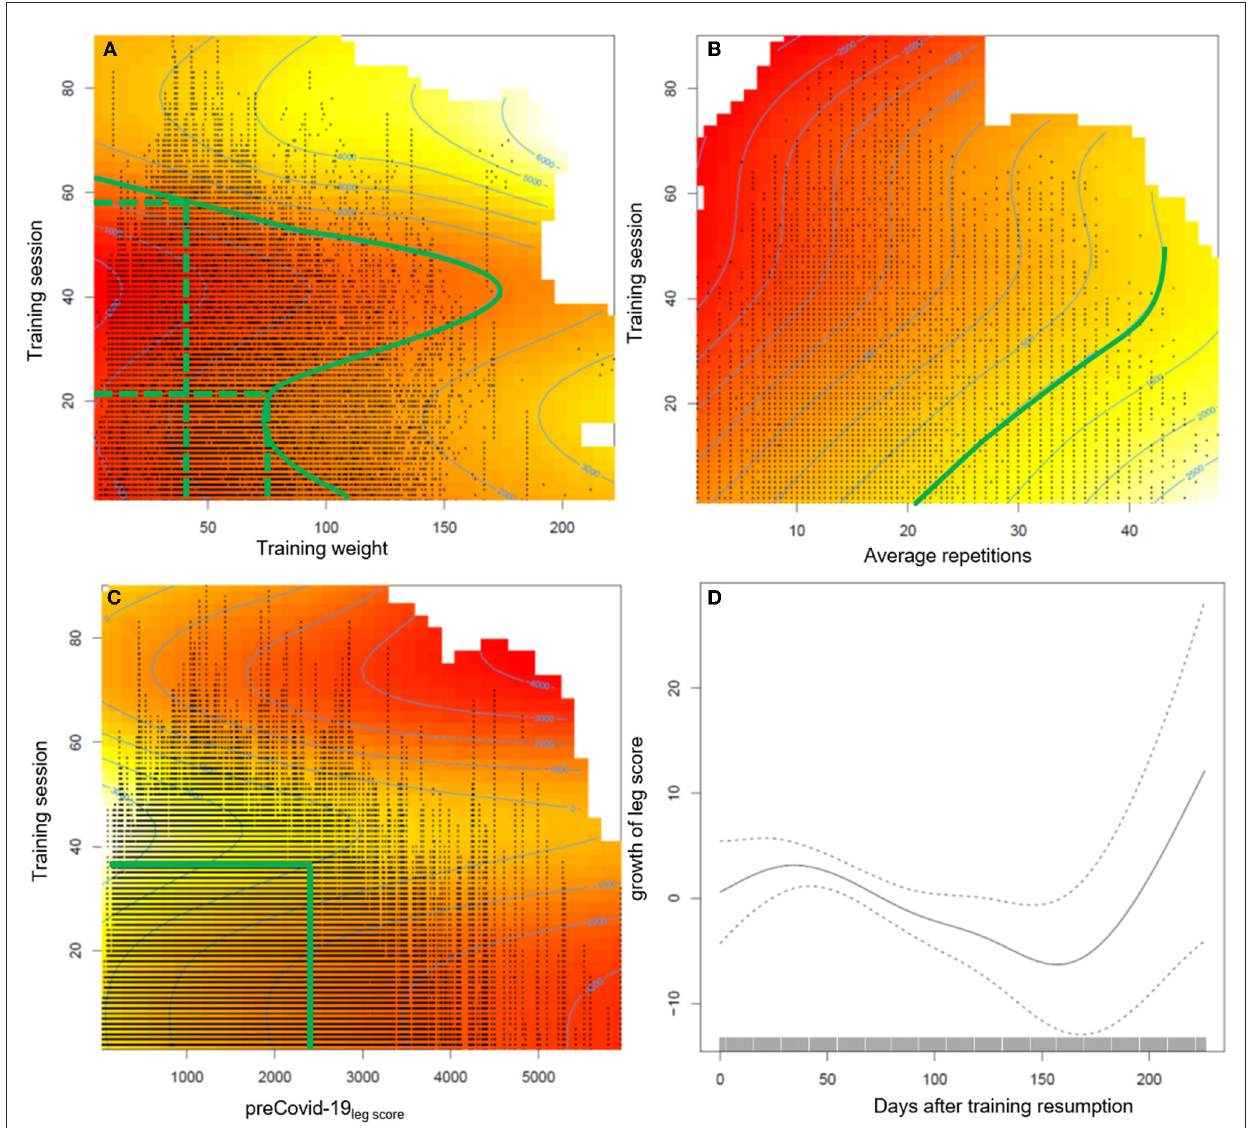
FIGURE2 Presentation of the estimated effects on the increase of the leg score of (A) average training weight per repetition (sum of lifting and lowering the training weight), (B) average repetitions per set, (C) pre-COVID-19 legscore , and (D) the number of days after training resumption during the post lockdown training sessions. The heat maps include contour lines, which denote increase or loss in the leg score compared to the first training session after the lockdown. As the intercept of the model is − 598.06kg, the zero line still indicates a loss in training performance of at least ≈ 600kg compared with baseline level, the difference will be larger depending on age and gender. Therefore, we marked the contour line 1,000 in (A, B) which indicates recovery of baseline values. The red color indicates a permanently reduced leg score until October